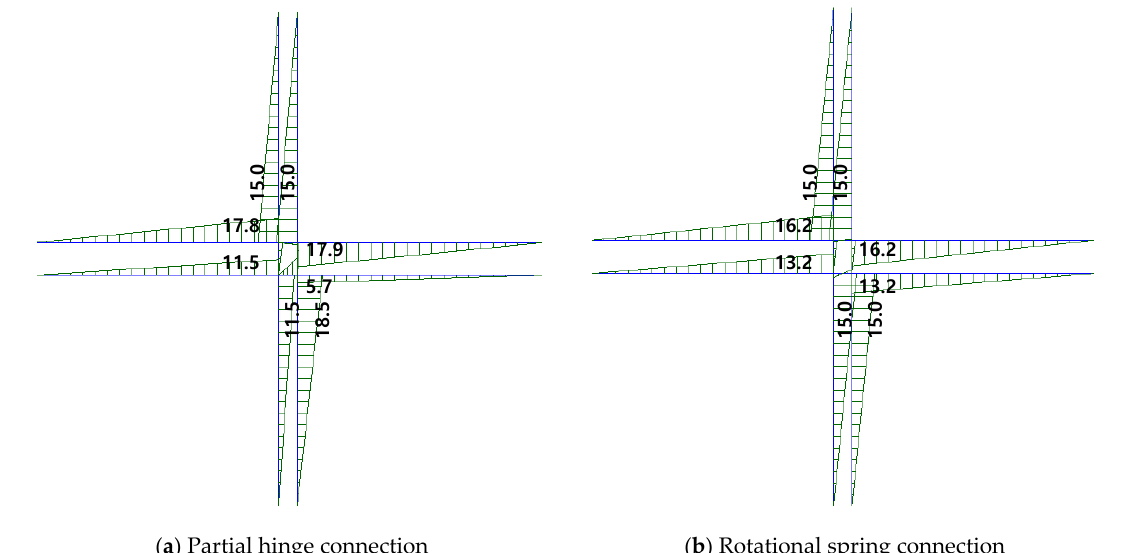
Figure 18. Linear elastic moment distribution of IC_OB_F specimen at P = 20 kN. (unit: kN·m).